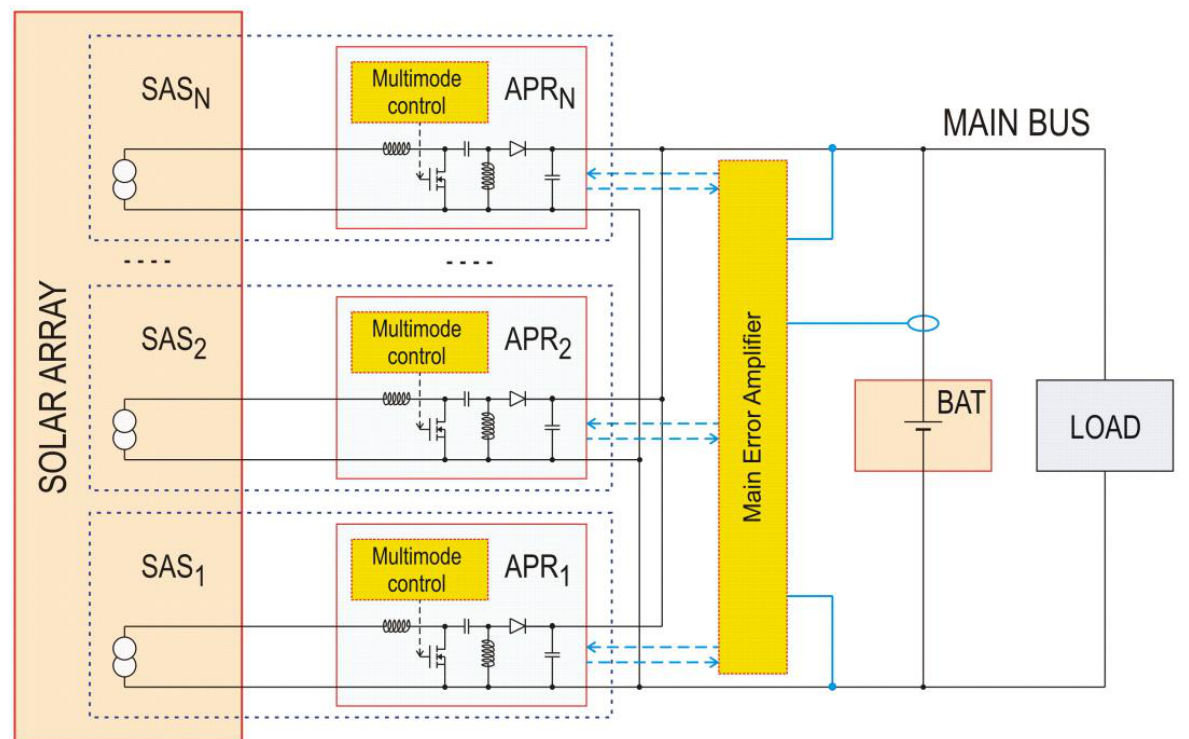
Figure 3. Power Module with SMPT solar array regulation.